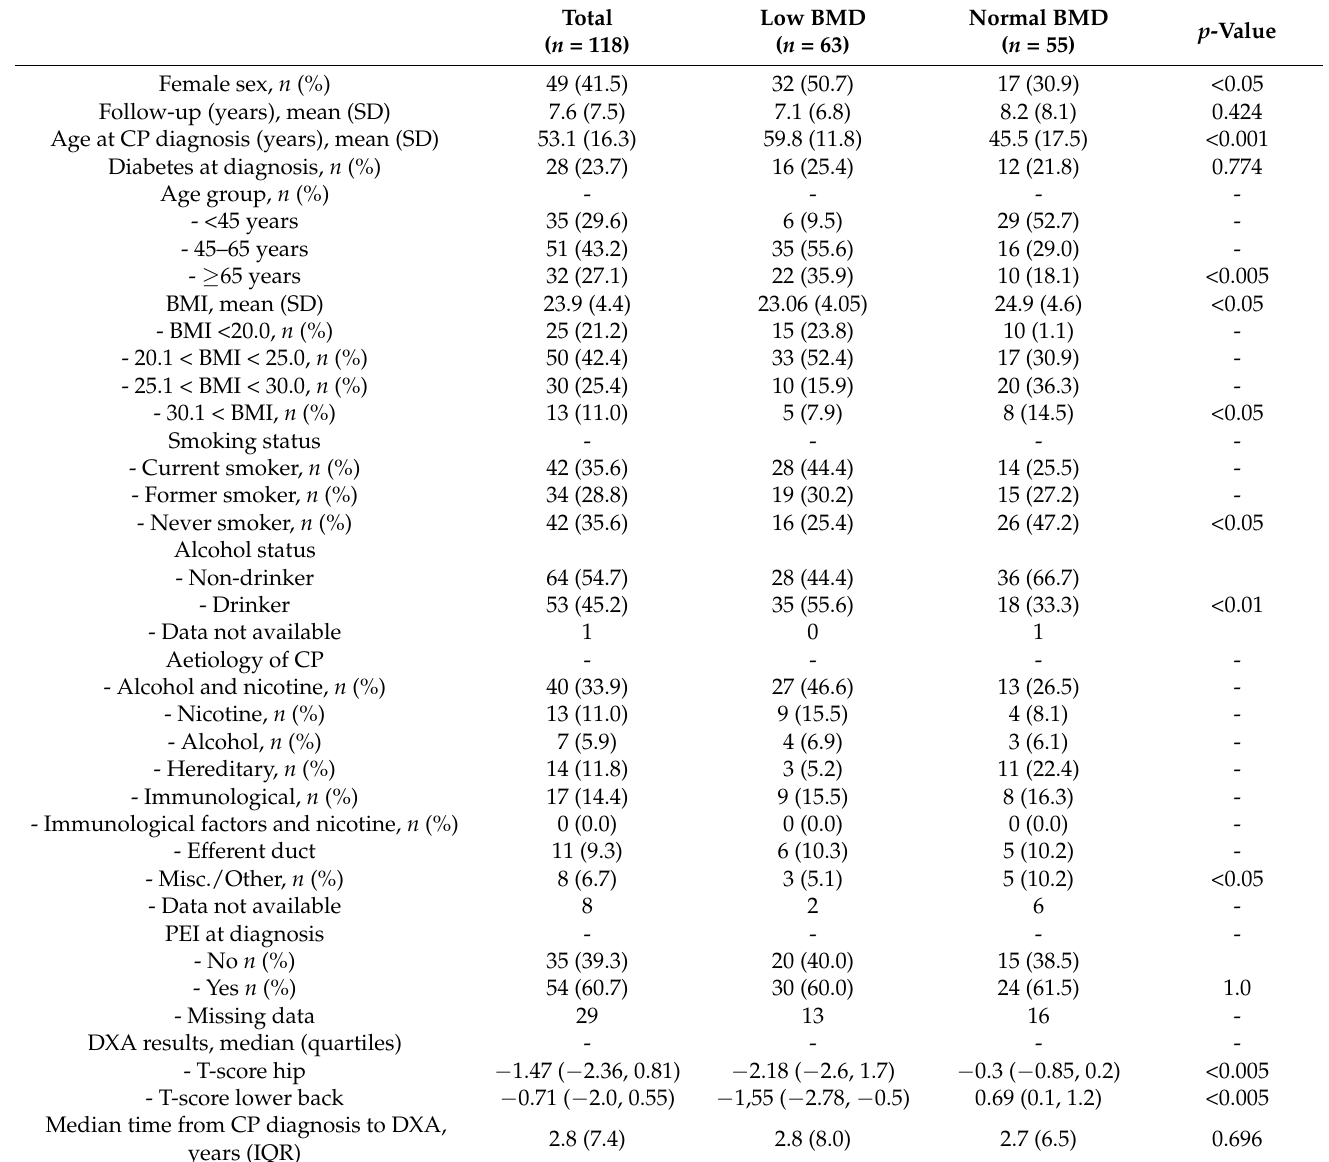
Table 1. Baseline patient characteristics.